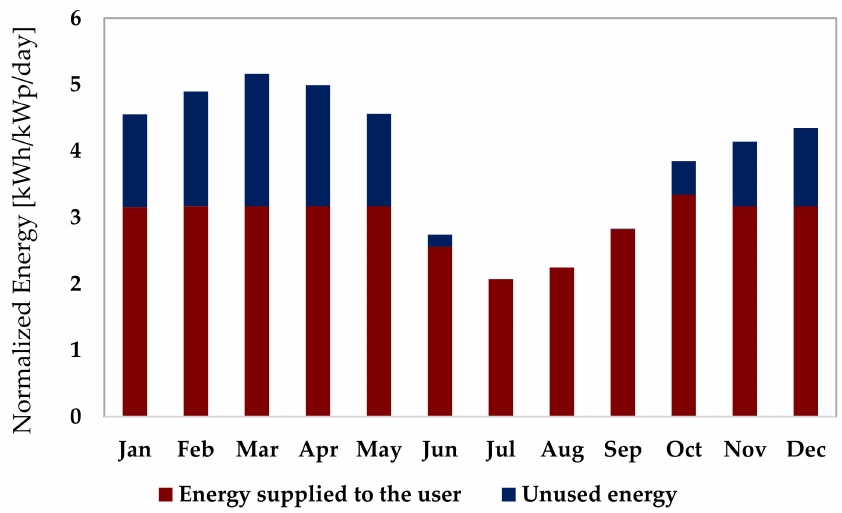
Figure 22. PVGIS5 Monthly PV energy output estimates.